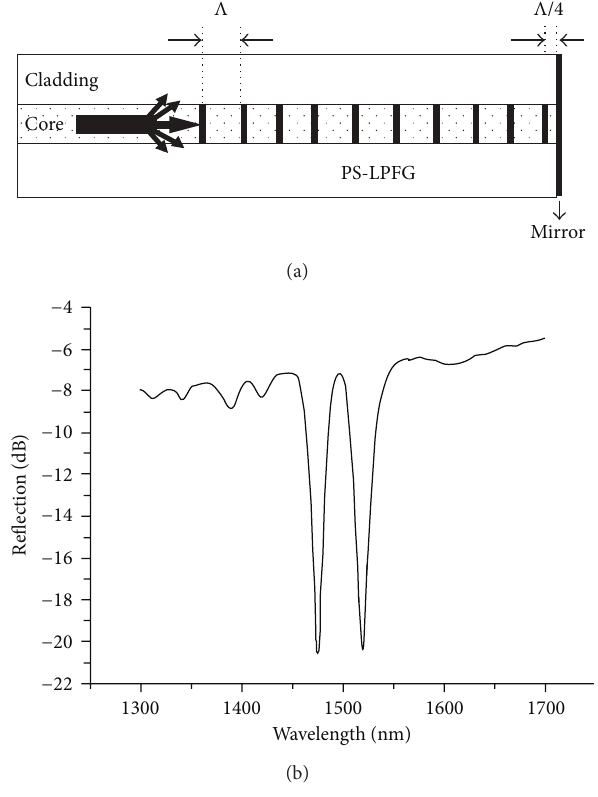
Figure 6: (a) Reflection configuration based on a 𝜋 -shifted LPFG; (b) spectrum of the bandpass filter (taken from [32]).